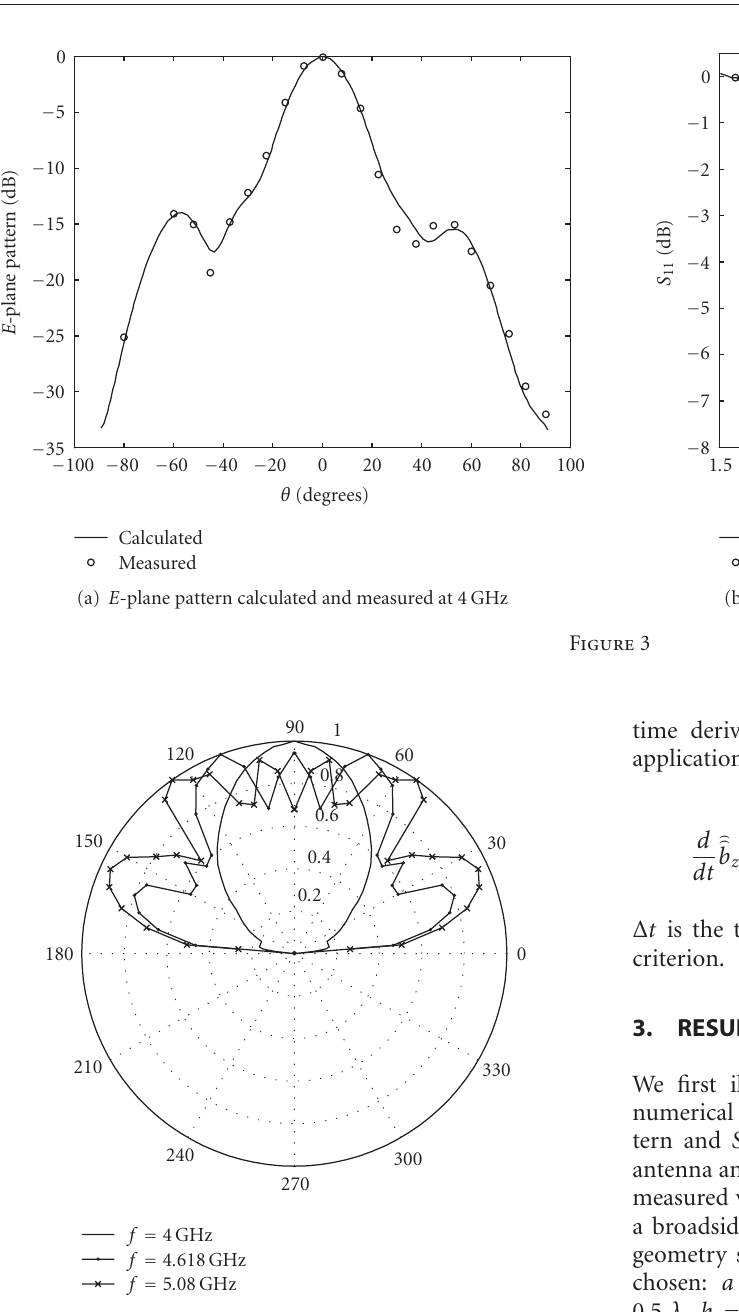
Figure 4: E -plane pattern for f = 4 . 0, 4.618, and 5.08